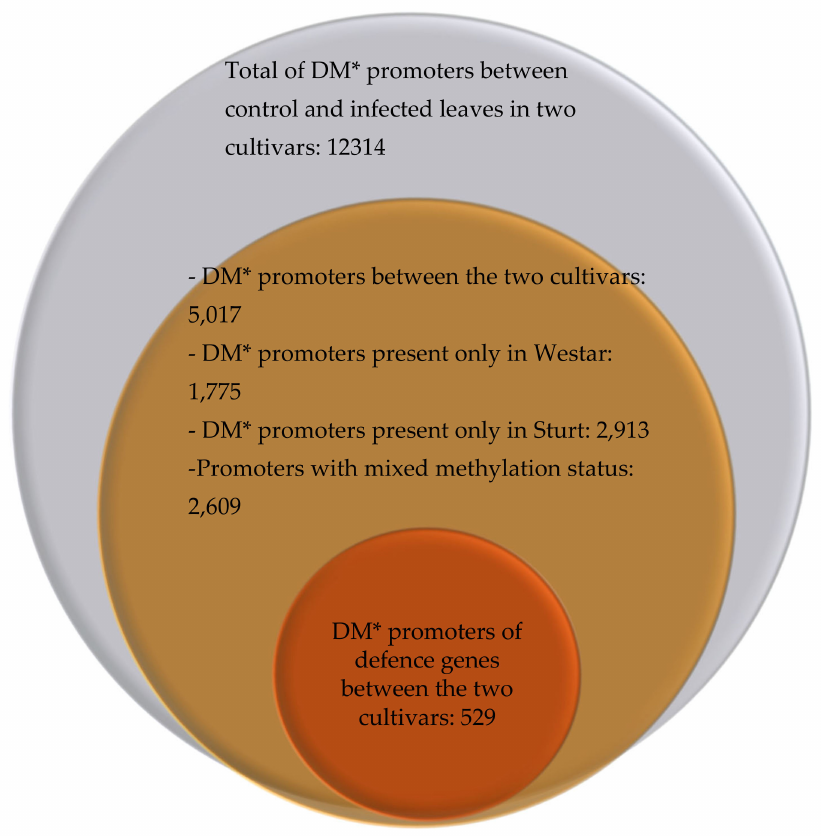
Figure 2. Total number of di ff erentially methylated promoters between leaves from control plants and leaves from infected plants with Leptosphaeria maculans of B. napus cultivars Westar (susceptible) and Sturt (resistant). *Di ff erentially